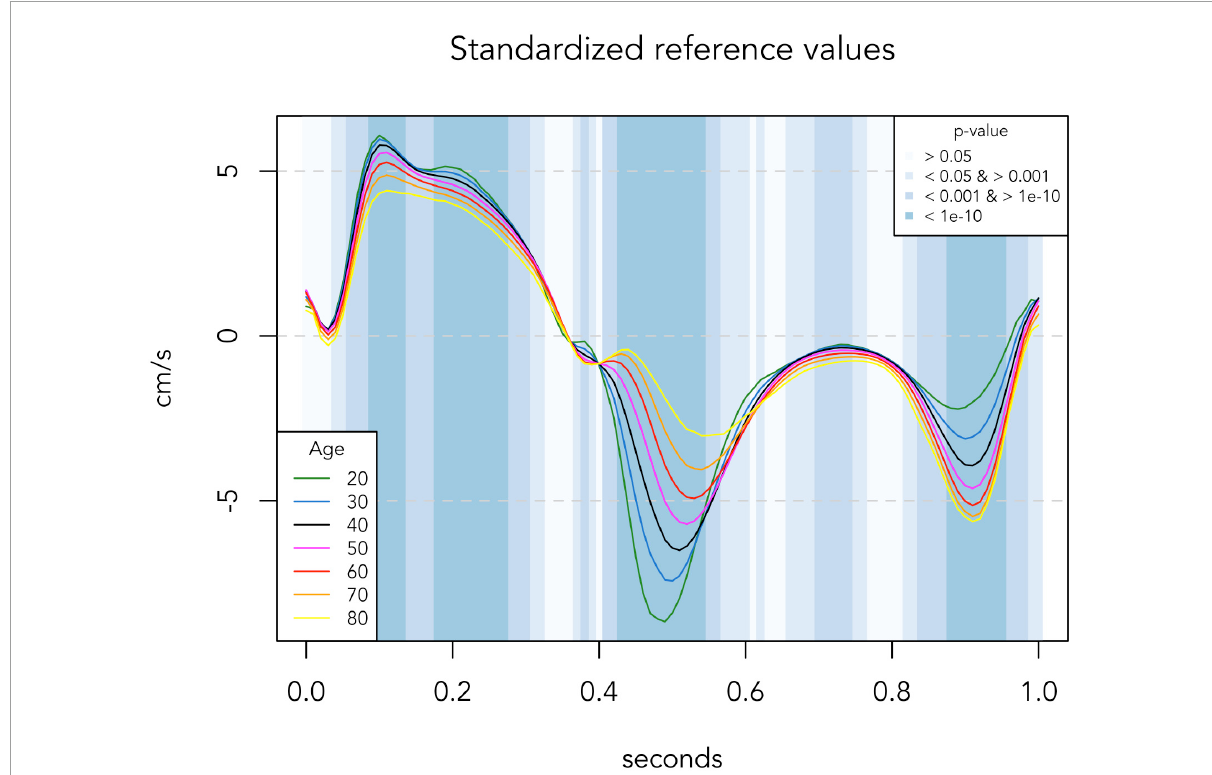
FIGURE1 Regression-based reference TDI curves of the low-risk population ( n = 881). Colored lines represent reference TDI curves for each age. Background colors indicate significance levels of the association between age and TDI values at each 0.01 s time-position. TDI values are averaged for septal and lateral mitral sites, presented for one standardized heart cycle of 1